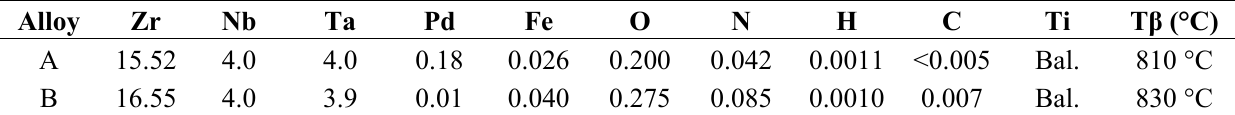
Table 1. Chemical compositions (mass%) and T β values of Ti-15Zr-4Nb-4Ta alloys used.